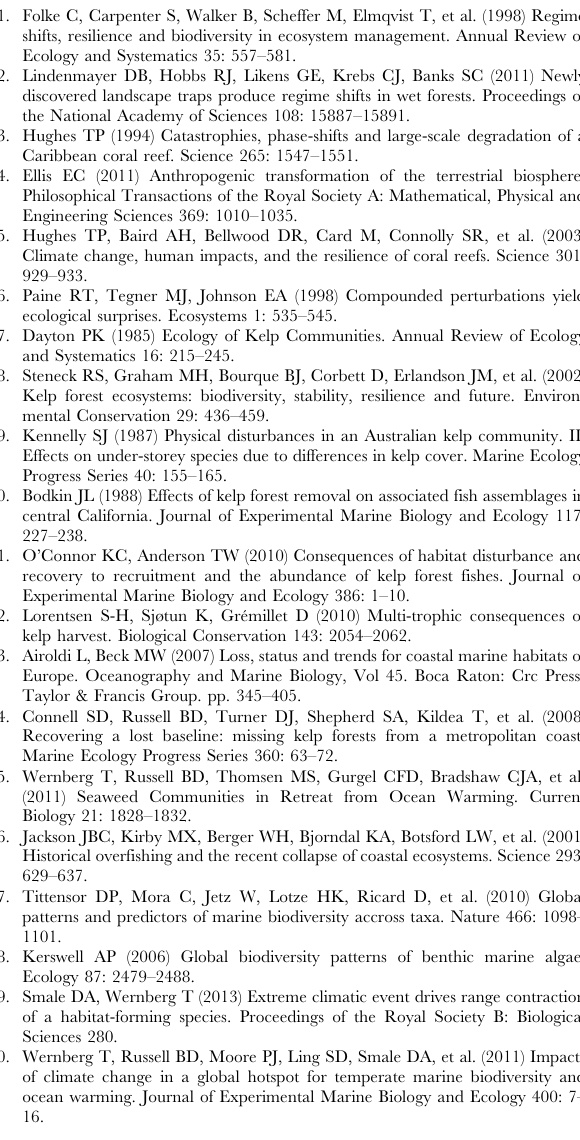
Table S5 Analysis of % cover of epibiota on Phyllospora ( n = 7) five months after the second experimental transplant. Treatment was fixed with 4 levels (U, TL, TP-LB, TP-CB), Place of origin was random with 2 levels (Cronulla, Palm Beach). Cochran’s test for homogeneity of variances: C =0.95, P , 0.01. Table S6 Analyses of lengths of recruits at several distances from restored (R) or reference (Ref) patches of Phyllospora six months after the start of the second experiment. Distance was fixed with 2 levels (inside, edge), R vs Ref was fixed with 2 levels, Place was random nested in RvRef (1 level for R, 2 for Ref), Patch was random nested in Place (1 level for R, 2 for Ref). Lengths of recruits were averaged per quadrat ( n =5). Data were